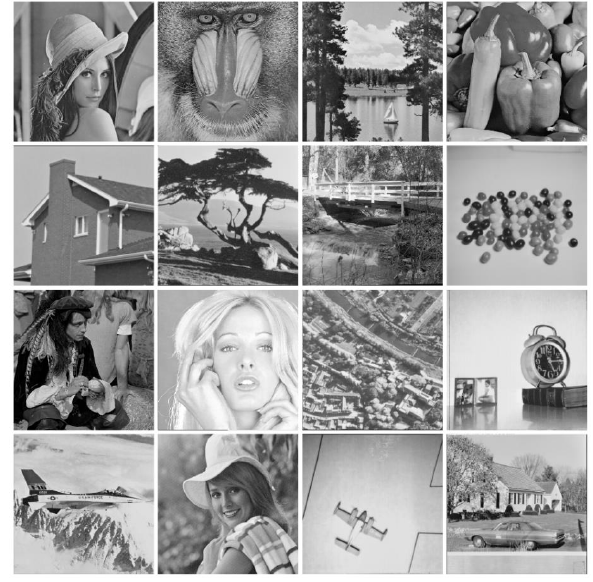
Figure 10. A set of images, named as Image Set 2, for experiment.